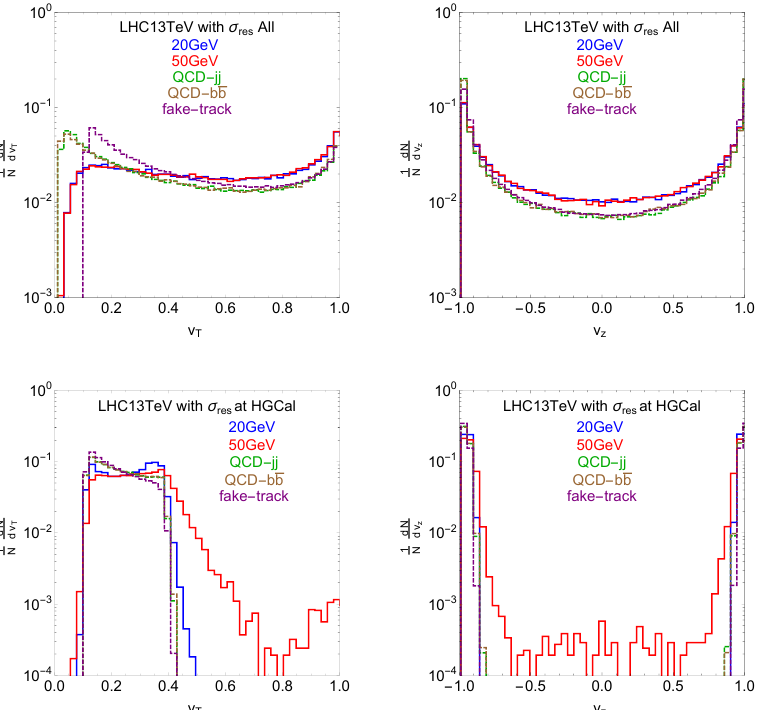
Figure 8 . The distributions of transverse velocity v T and longitudinal velocity v z for the tracks without (upper panel) and with (lower panel) the requirement to arrive at